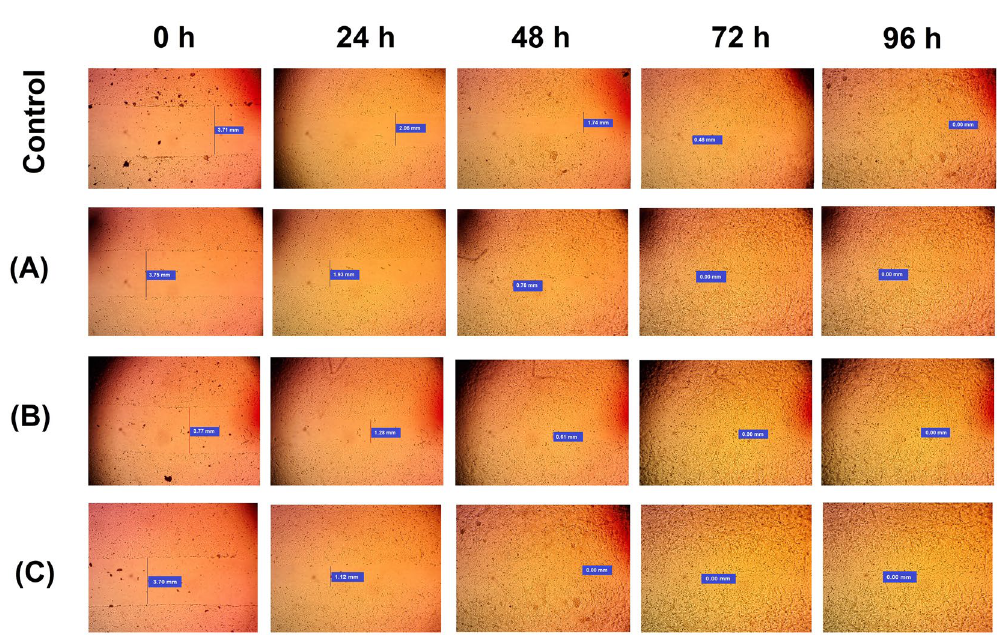
Figure 3. Wound healing potential of CoFeNPs ( A ), SeNPs ( B ), and ZnONPs ( C ).